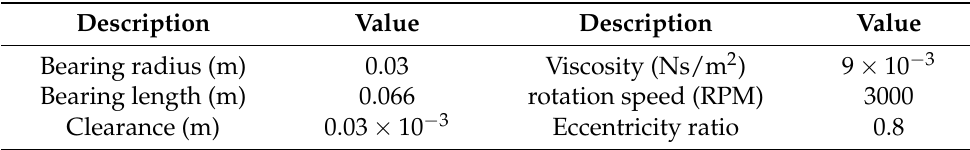
Table 4. Parameters of HDB provided by Sun and Changlin [20].